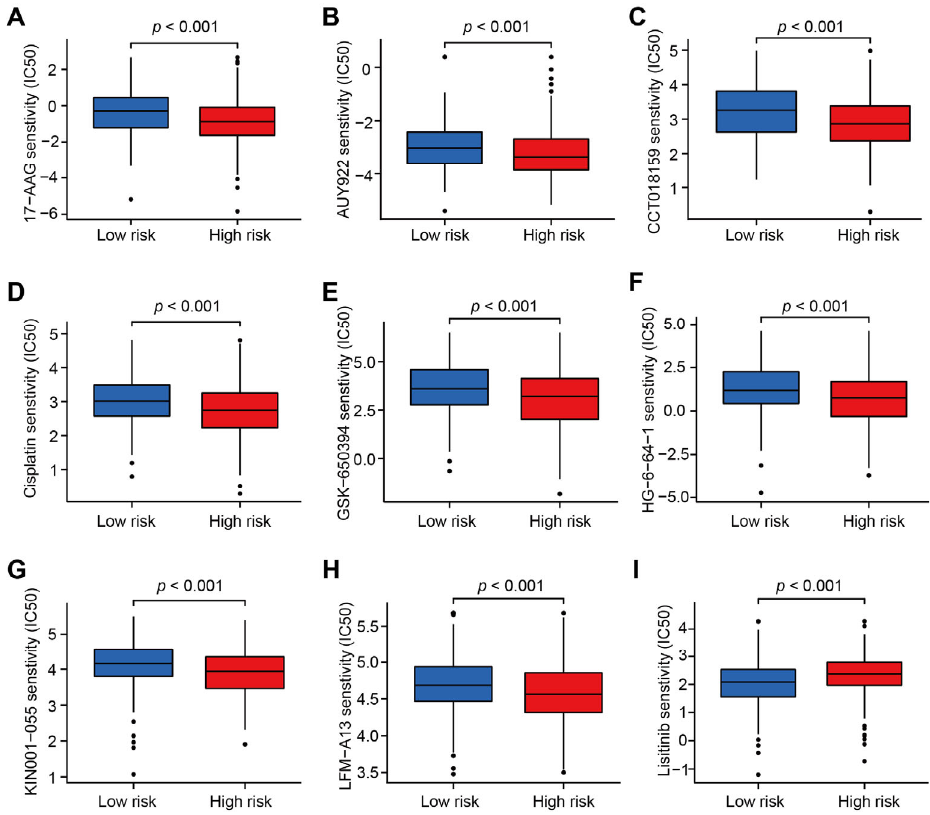
Figure 8. Sensitivity of targeted therapy drugs in CC patients from different risk groups. ( A – I ) Box plot depicting the IC50 value of 17 ‐ AAG ( A ), AUY992 ( B ), CCT018159 ( C ), Cisplatin ( D ), GSK ‐ plot depicting the IC50 value of 17-AAG ( A ), AUY992 ( B ), CCT018159 ( C ), Cisplatin ( D ), GSK-650394 650394 ( E ), HG ‐ 6 ‐ 64 ‐ 1 ( F ), KIN001 ‐ 055 ( G ), LFM ‐ A13 ( H ), and Lisitinib ( I ) in CC patients from dif ‐ ( E ), HG-6-64-1 ( F ), KIN001-055 ( G ), LFM-A13 ( H ), and Lisitinib ( I ) in CC patients from different ferent CRLs ‐ risk groups. CRLs-risk